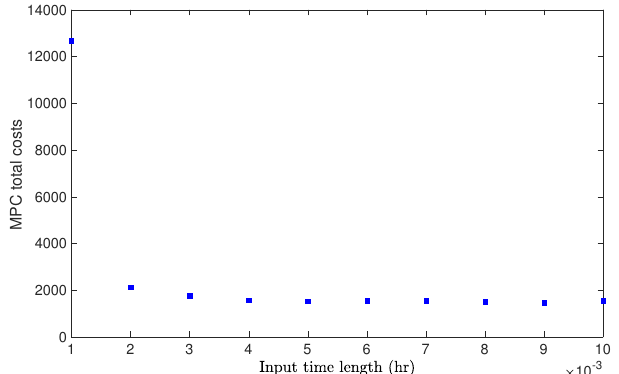
Figure 22. MPC total costs vs. input time